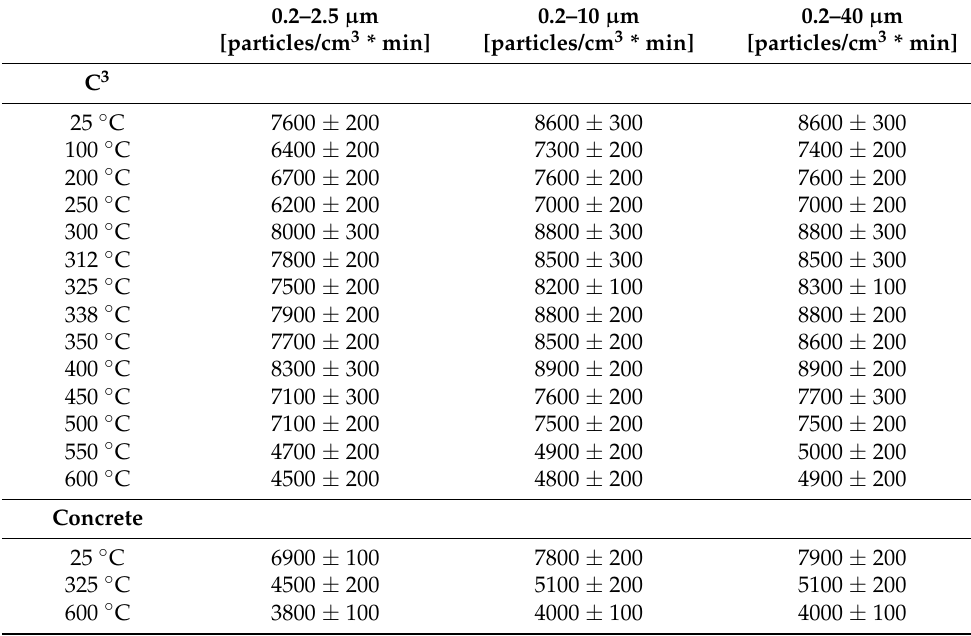
Table 1. Concentrations of inhalable PM fractions with scattered light equivalent diameters